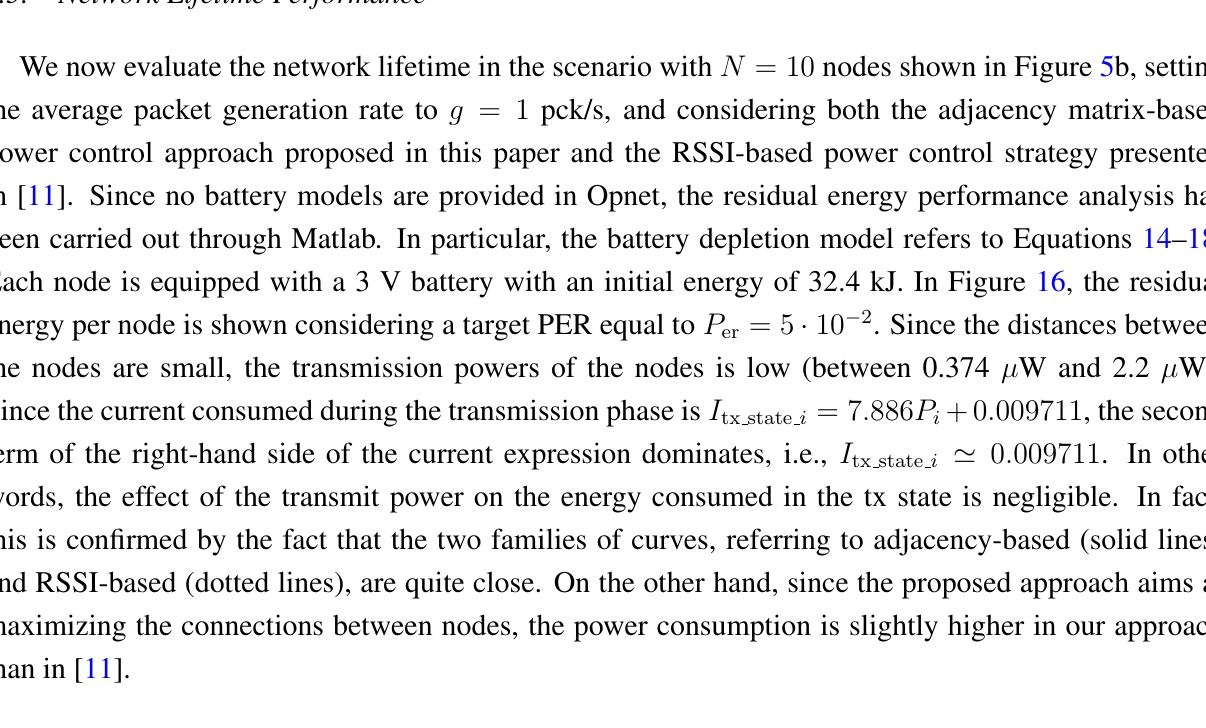
Figure 16. Residual energy per node. Both RSSI-based and adjacency-based transmit power allocation schemes are considered. The given PER is P